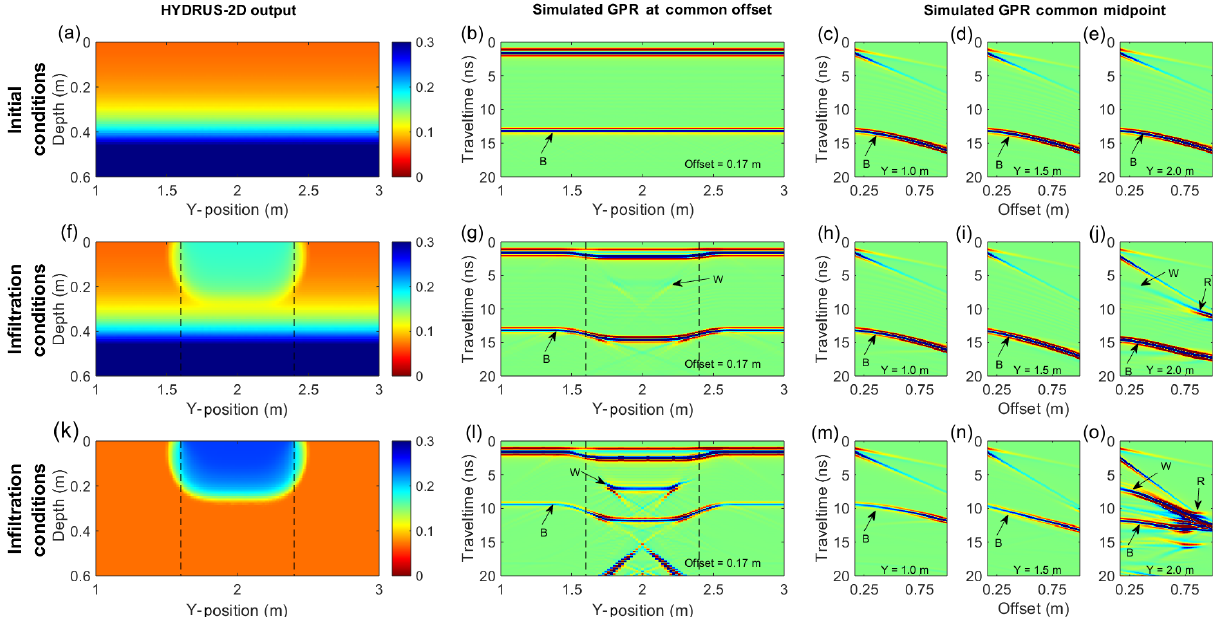
Figure 2. Panels (a) , (f) , and (k) show volumetric moisture distribution from HYDRUS-2D simulations used to generate simulated common- offset GPR data (b, g, l) and multi-offset GPR data ( c–e , h–j , and m–o ). Vertical dashed lines indicate the extent of the wetted surface. Annotated arrivals are the bottom of sand layer reflection ( B ), wetting front reflection ( W ), and refraction ( R ). Note that the base of the sand reflection ( B ) is caused by the boundary at 0.60m depth between the sand and gravel, not the capillary rise shown in panels (a) and (f) .